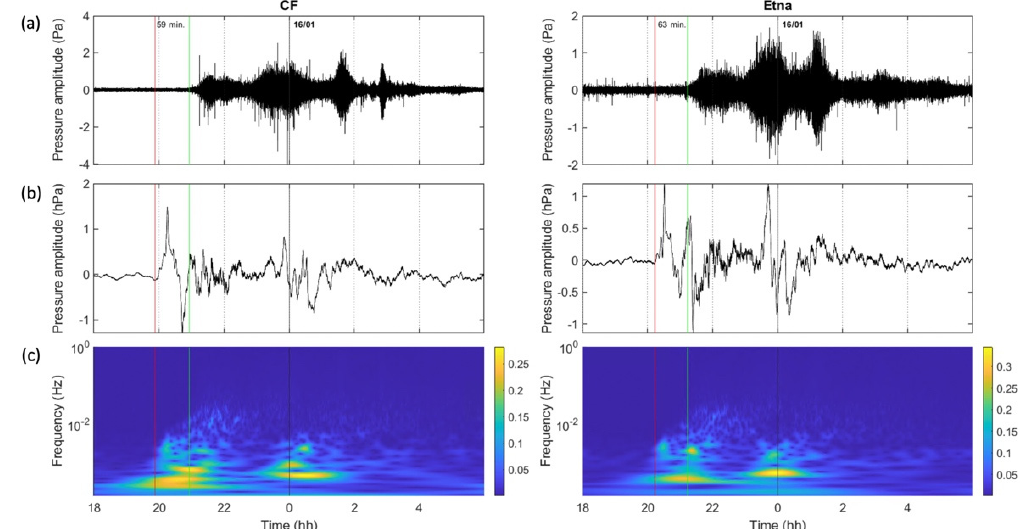
Figure 2. ( a ) Infrasound waveforms at Campi Flegrei (CF) and Etna stations showing the acoustic wave arrival; the signal is filtered with a low-pass filter with 10 Hz cutoff. ( b ) Barometric waveforms, showing the Lamb wave arrival; the signal is filtered with a high-pass filter with 0.093 mHz (3 h